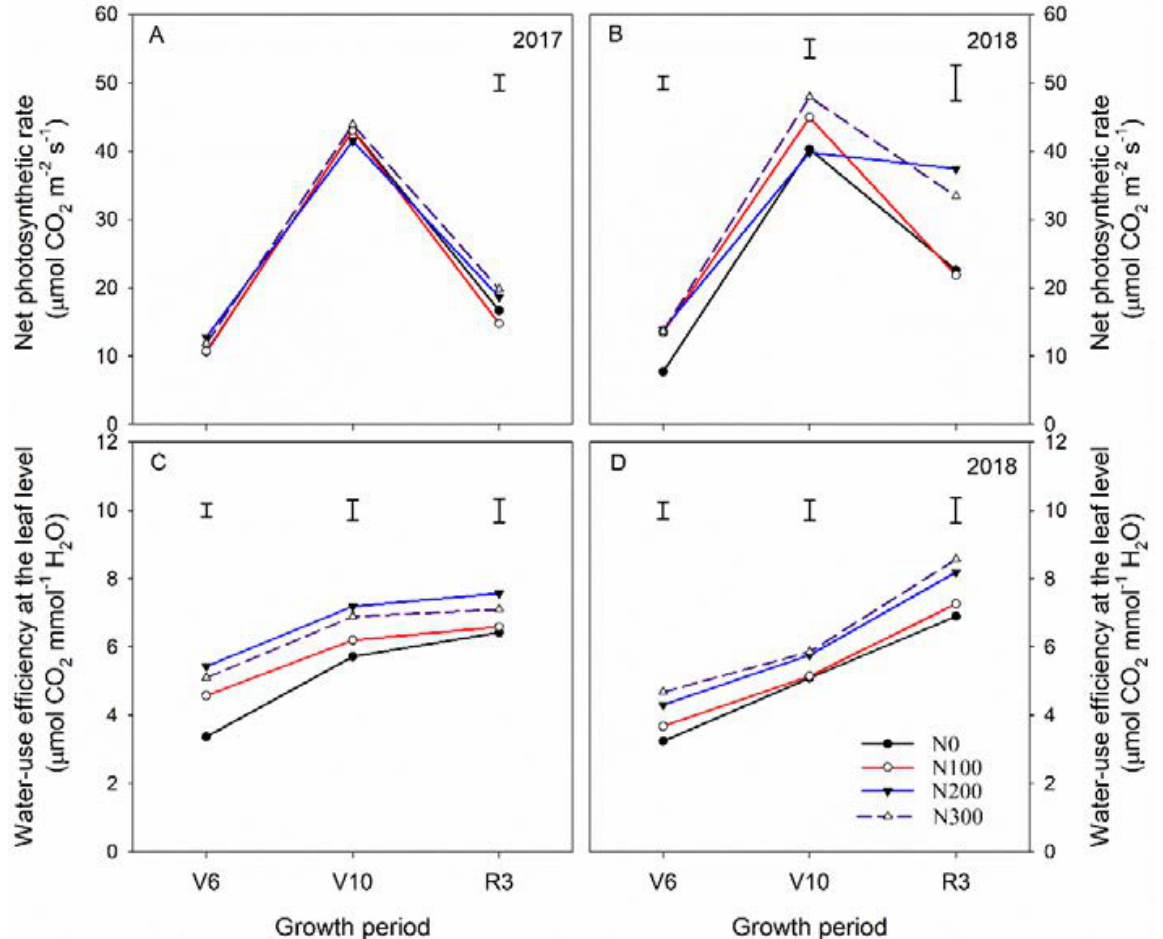
Figure 3. Net photosynthetic rate ( A , B ) and water use efficiency at the leaf level ( C , D ) in different growth stages in 2017 and 2018. Vertical bars denote Fisher’s protected least significant difference at p ≤ 0.05. V6, V10, and R3 indicate the 6-leaf collar stage of maize, the 10-leaf collar stage of maize, and the milk stage of maize, respectively. Table 2. Average aboveground nitrogen (N) accumulation at physiological maturity, N harvest